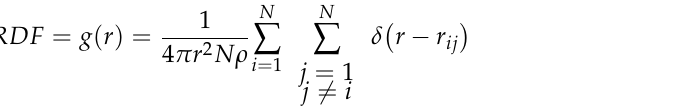
Figure 8. The atomic structure at the second stress peak. ( a ) Fe2C model, ( b ) Fe3C model, ( c ) Fe4C model, and ( d ) Fe7C3 model. The red atoms represent the dislocation atoms and the gray atoms represent the FCIs atoms.